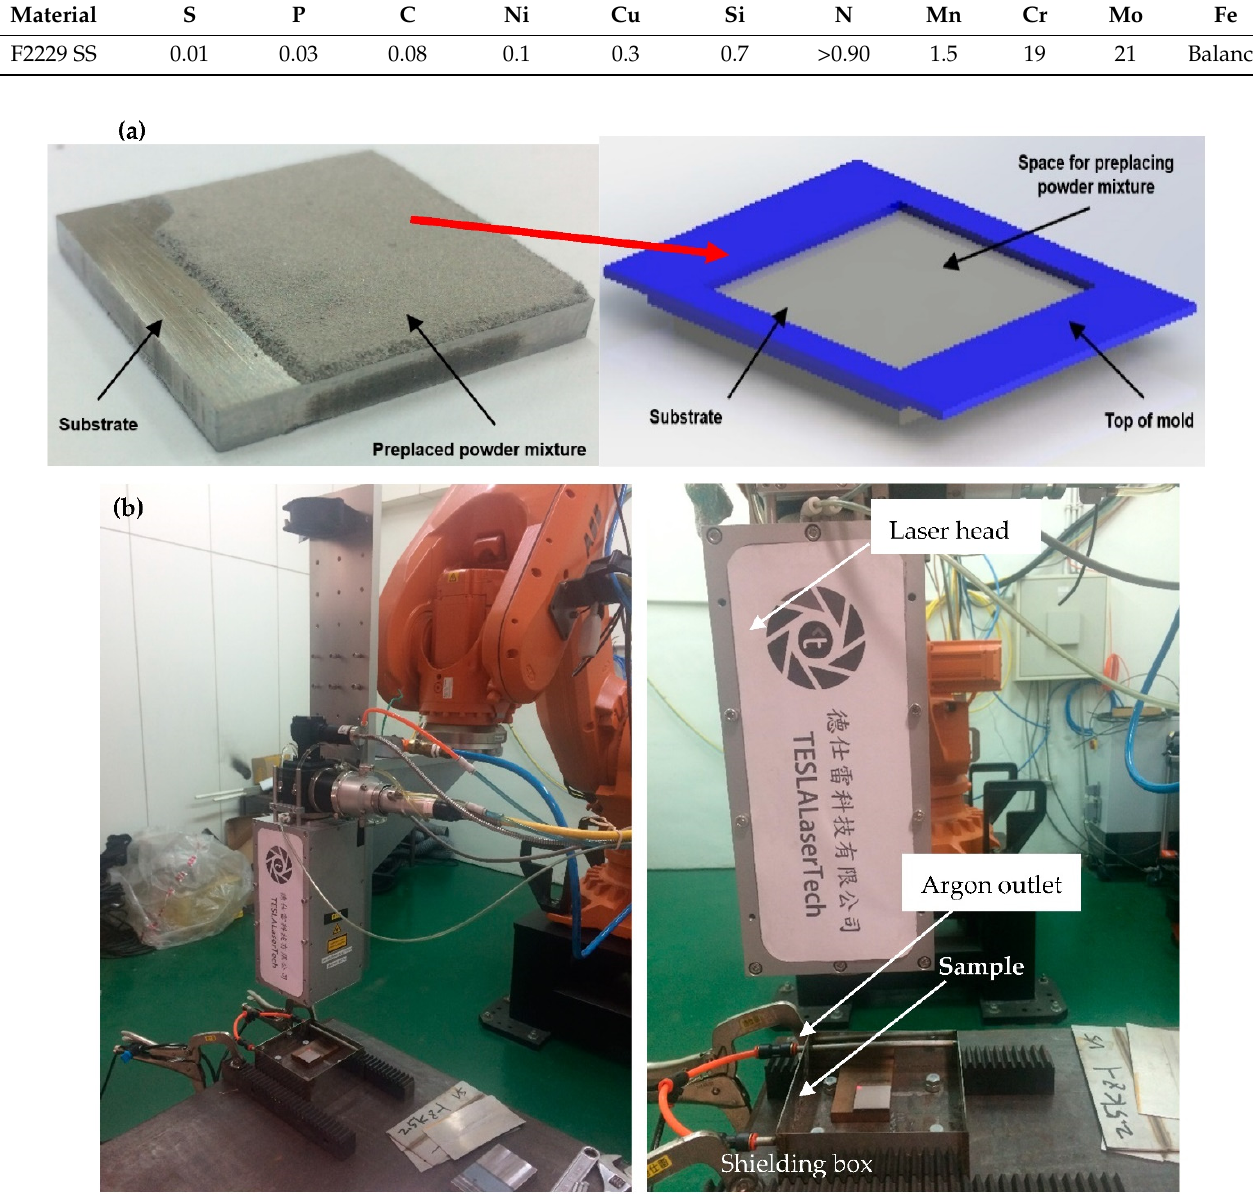
Figure 1. ( a ) Setup used to preplace the Fe-based amorphous powder, ( b ) laser cladding setup